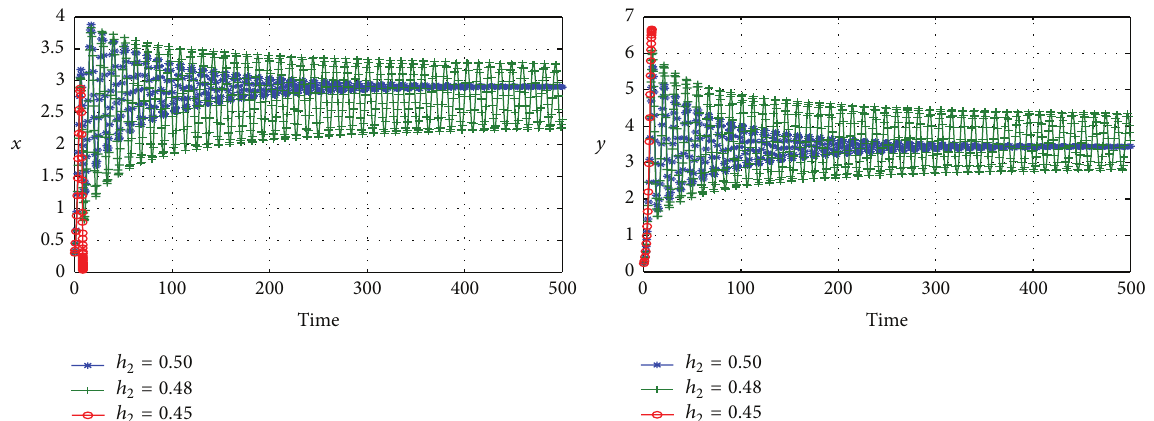
Figure 7: When 𝜏 = 2.7 < 𝜏 0 ≈ 2.8015 and ℎ 2 decreases, prey species 𝑥 and predator species 𝑦 become unstable.